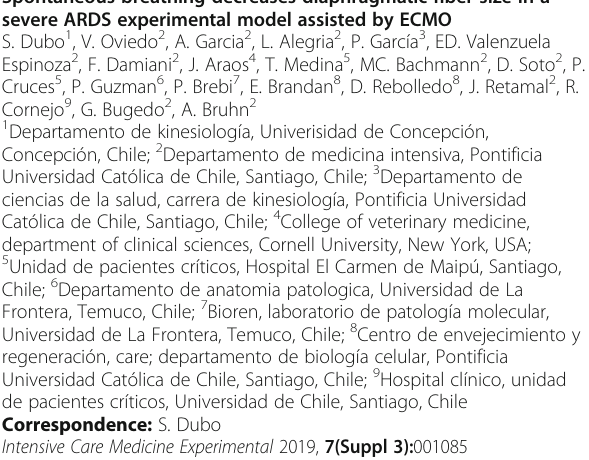
maneuver the time between the blue asterisk and red cross is